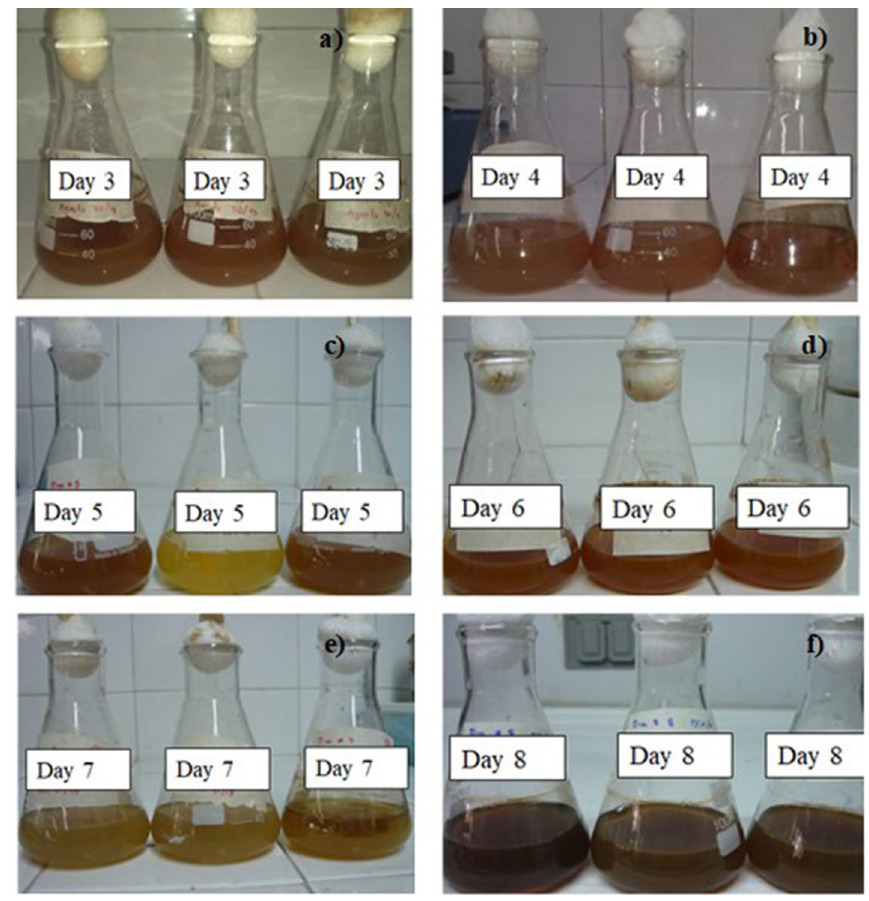
Figure 6. Formation of AgNPs after ( a ) 48 h of being incubated using a concentration of 1 Mm AgNO 3 for different growth times of the fungus anamorphous Bjerkandera sp.